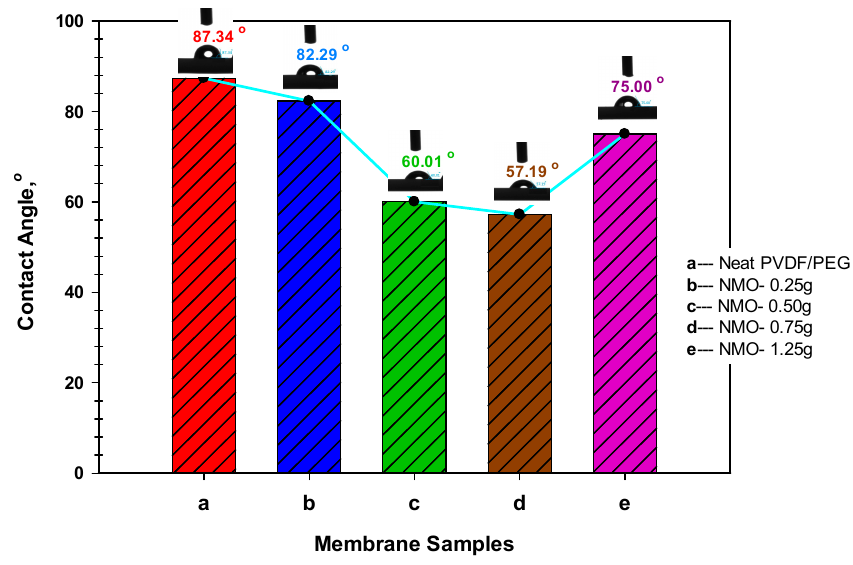
Figure 3. Hydrophilicity of neat PVDF-PEG (a), and modified Nano-hybrid membranes (b–e) with the respective goniometric images after 30 second of contact.